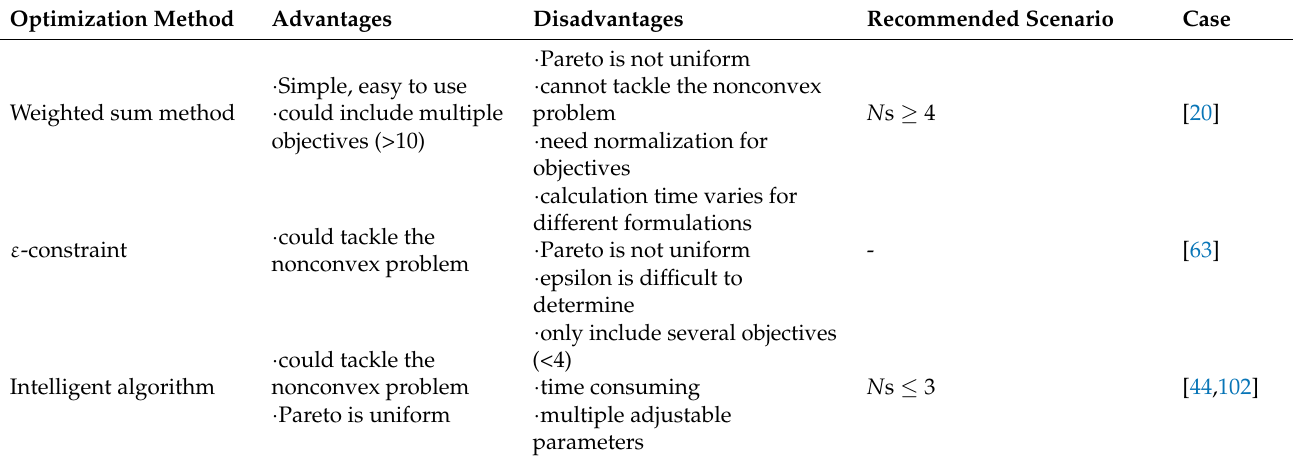
Table 3. Comparison of different multi-objective optimization